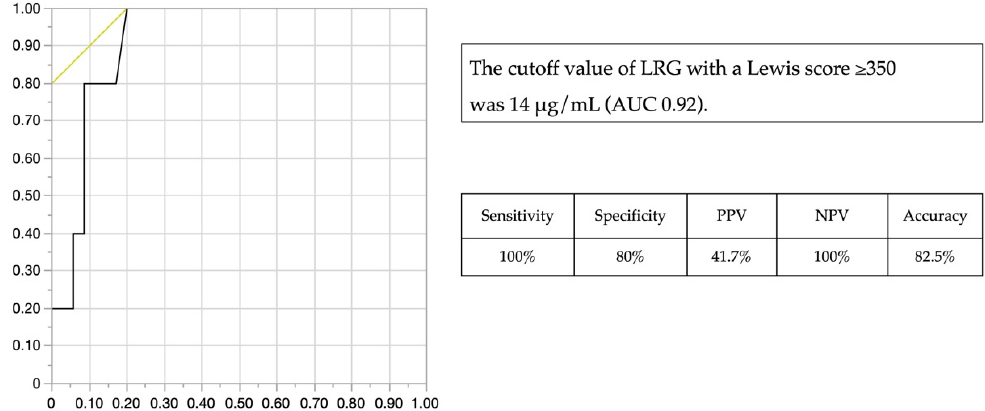
Figure 3. ROC curve of LRG for LS ≥ 350. AUC; Area under the curve, LRG; Leucine-Rich Alpha-2 Glycoprotein, LS; Lewis score, NPV: negative predictive value, PPV: positive predictive value, ROC; Receiver operating characteristic.